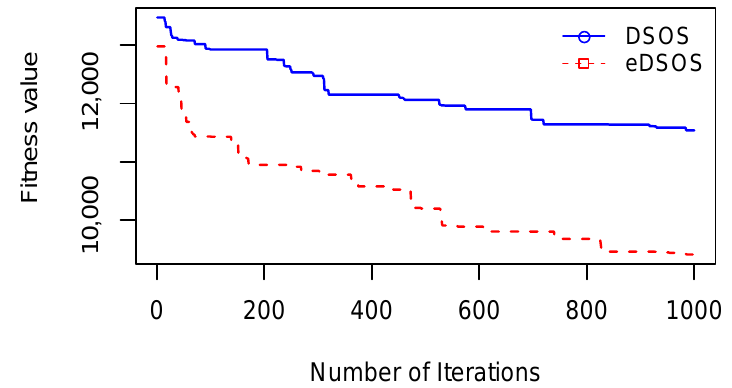
Figure 12. The convergence curves with 500 instances of